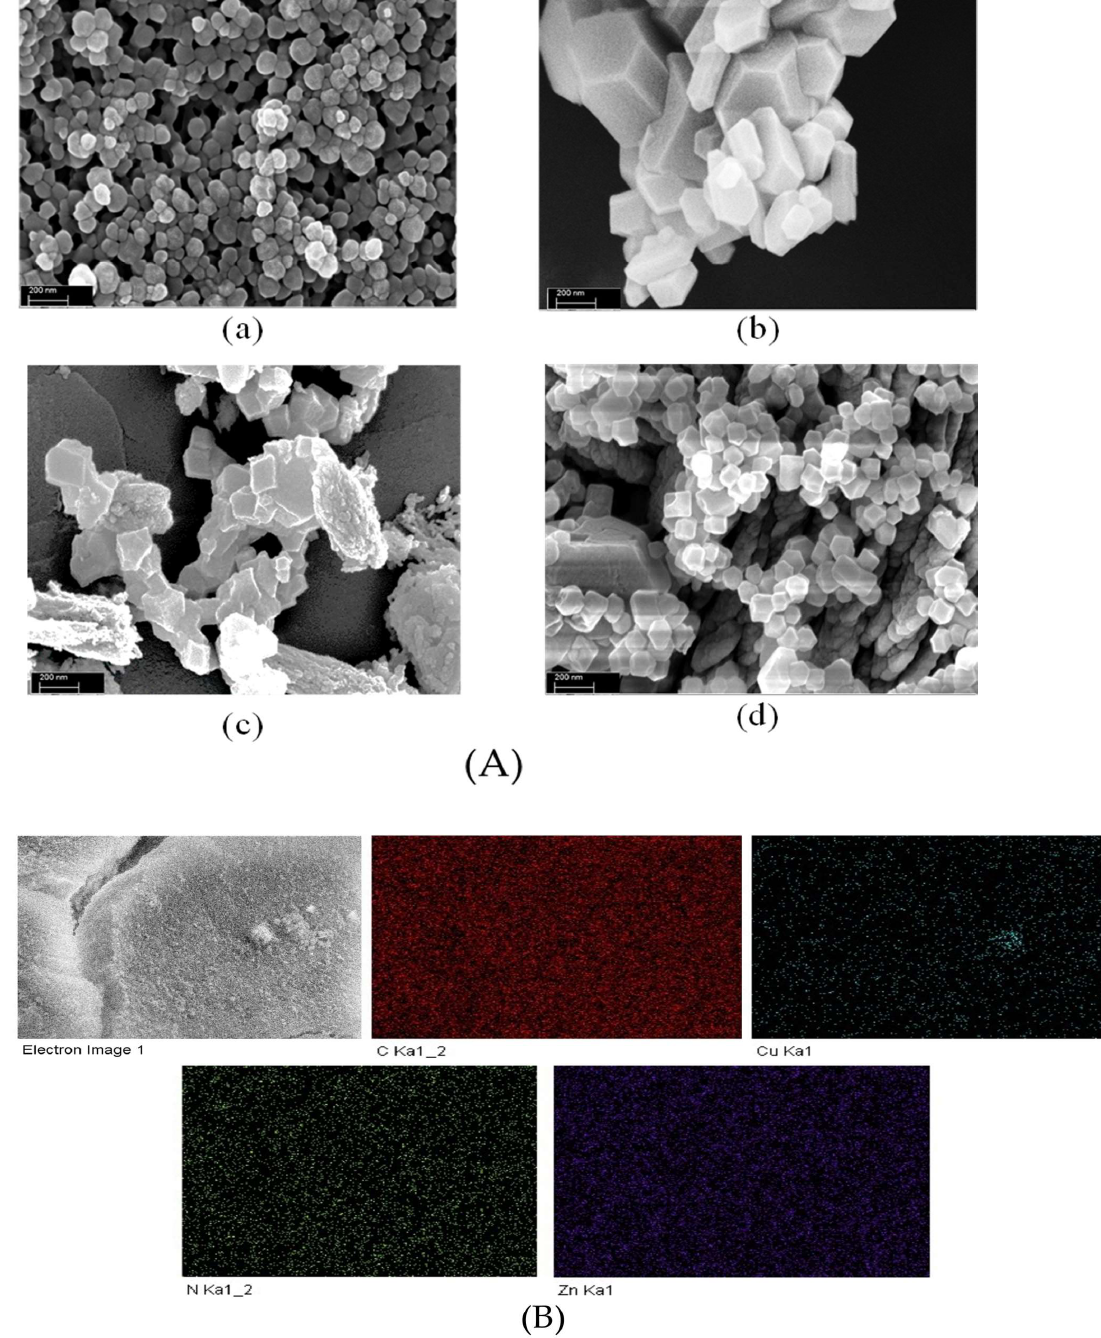
Figure 2. FESEM images of ( A ) ( a ) ZIF-8 (b) 2Cu/ZIF-8N4 ( c ) 2Cu/ZIF-8N3 ( d ) 2Cu/ZIF-8N2 and ( B ) dot mapping images of